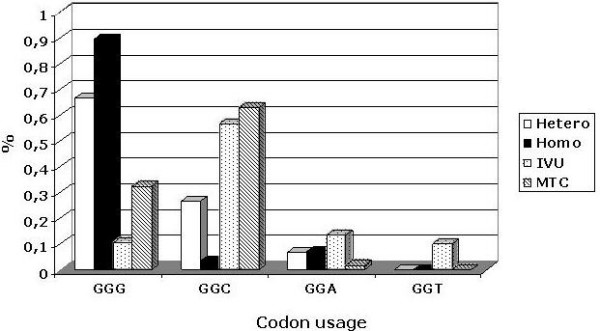
Distribution of codons in risk groups. The distribution of the four codons encoding the second glycine residue in the crown of the env gene V3 loop (GPGRAFYT) has been analyzed in HIV-1 sequences, identified in infected individuals with different risk practices.